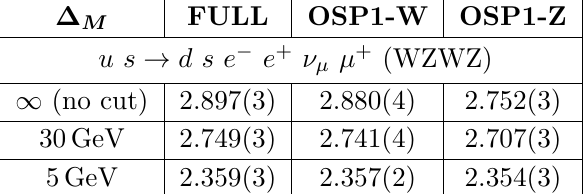
d s e (cid:0) e + (cid:23) (cid:22) (cid:22) + , for ! > 40 ‘ + ‘ (cid:0)